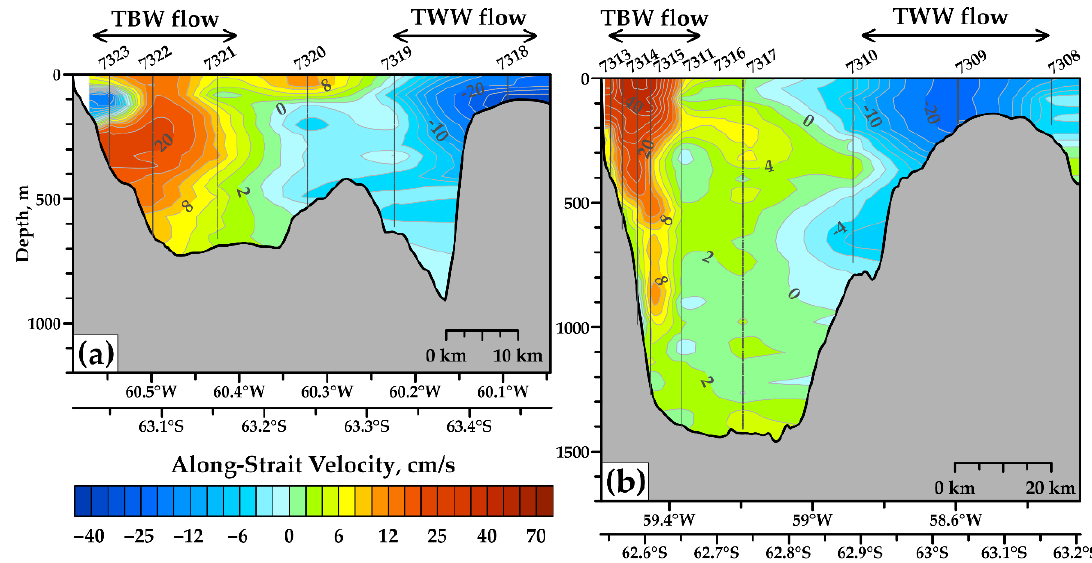
Figure 3. Along-strait LADCP velocity distributions at two sections across the BS: ( a ) Section 1 over the watershed between the WB and CB and ( b ) Section 2 in the CB. Locations of TBW and TWW flows are indicated at the top of each panel; stations are indicated by solid black lines. The bottom relief is shown according to the GEBCO2021 database.